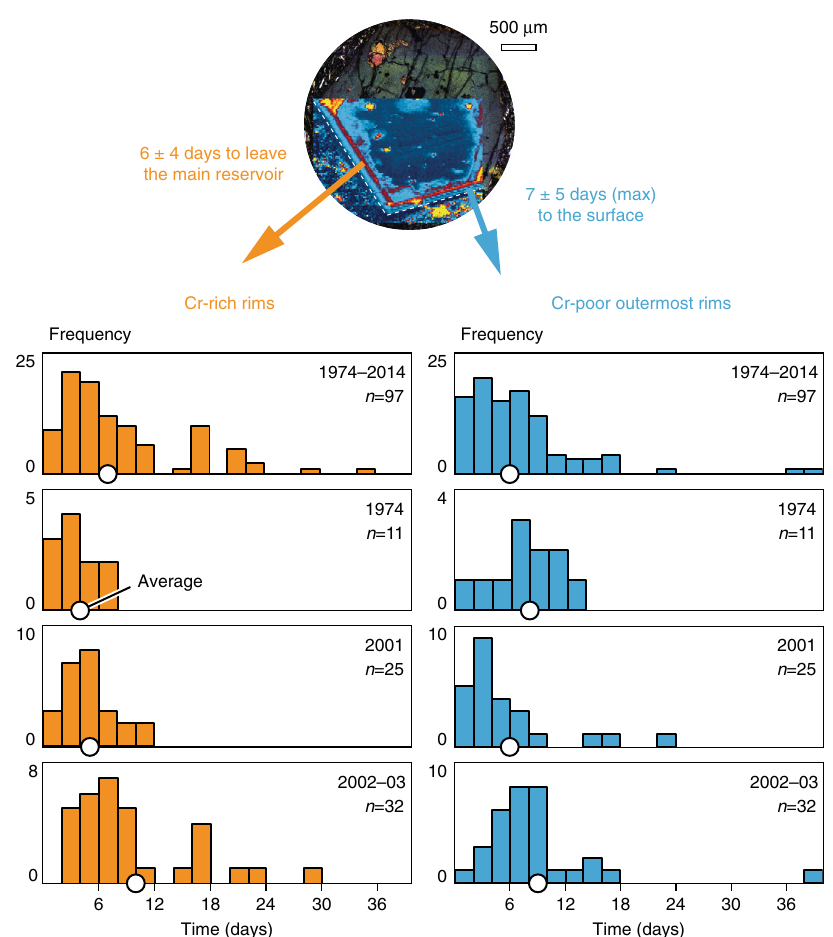
Fig. 5 Intrusion to eruption timescales calculated using the thickness of Cr-rich rims and Cr-poor outermost rims. The ‘ clinopyroxene clock ’ provides magma intrusion to eruption timescales of ~2 weeks. Timescales of crystallisation were calculated using an average clinopyroxene growth rate of 10 − 8 cm/s calculated for Mt. Etna 26,54,55 . Chomium-poor outermost rims potentially grew faster upon fi nal magma ascent and degassing 56 , so extracted timescales are considered maxima. The example Cr map is from the 2002 – 2003 eccentric eruption. The Cr-rich and Cr-poor timescale values on either side of the map are average fi gures for eccentric eruptions, where most antecrysts show rims crystallised from intruding magma (Fig. 3). The upper histograms include data from all studied eruptions (1974 – 2014) and the other histograms summarise data from individual eccentric eruptions. The white circles mark the average time value (days) per data set. Note the consistency of timescale results across 40 years of eruptive activity (Supplementary Table